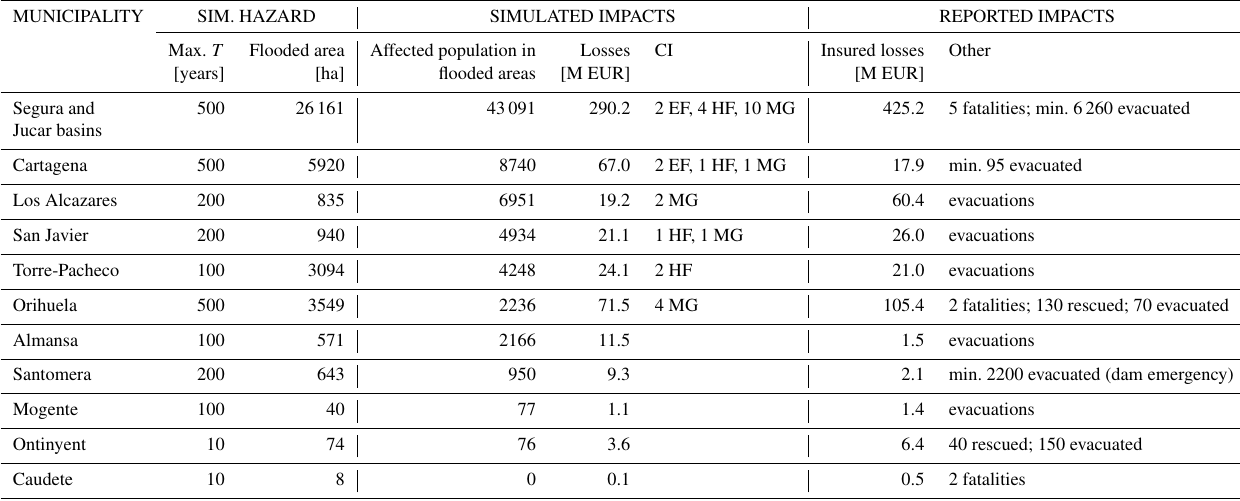
Figure 5. (a) Flash flood impacts simulated by ReAFFIRM (11–14 September 2019). (b) Reported flood impacts: insured economic loss by municipality (CCS, 2020), and locations of fatalities, rescues, and evacuations gathered by the media and the civil protection authorities (CRAHI, 2019; DGPCE, 2019). Map data © Google Earth 2015. Table 3. Summary of simulated flash flood impacts (ReAFFIRM) and reported flood impacts (CRAHI, 2019; CCS, 2020; DGPCE, 2019) in selected municipalities (11–14 September 2019; corresponding to Fig. 5). Critical infrastructure (CI) categorised as education facilities (EF), health facilities (HF), and mass-gathering sites